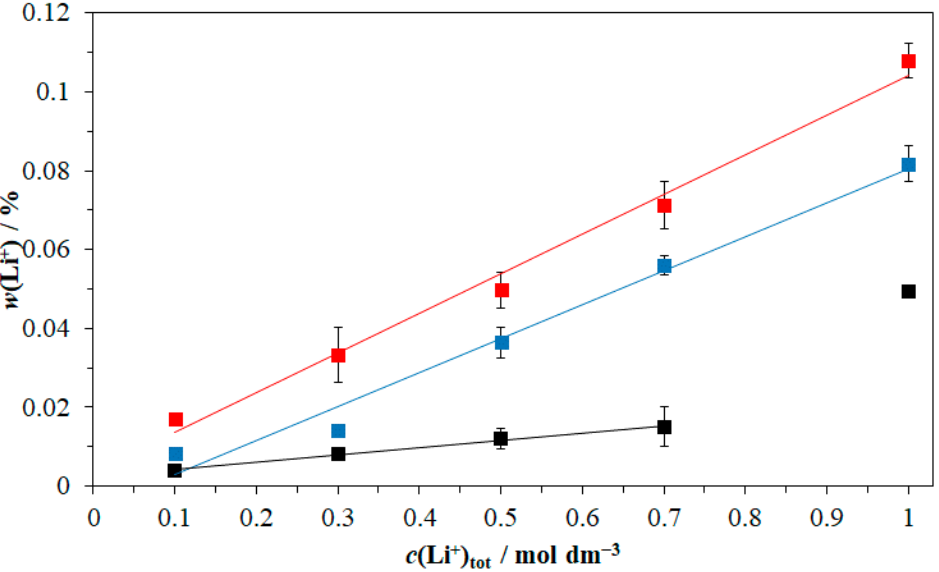
Figure 4. Amount of lithium incorporated in precipitate separated after 5 days of aging in the systems with different initial stirring modes (mechanical mixing (red line), magnetic mixing (blue line) and ultrasonic irradiation (black line)) and different initial Li + concentrations.